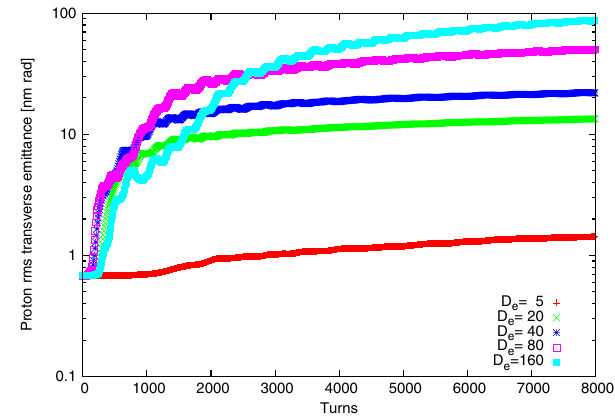
FIG. 4. The proton beam emittance growth due to the kink instability at different disruption parameters with the chromatic- ity of both transverse directions set at þ 2 units, and the beam- beam parameter of the proton beam at 0.015. The scale of the y axis is a logarithm to make the emittance growth of the d e ¼ 5 case